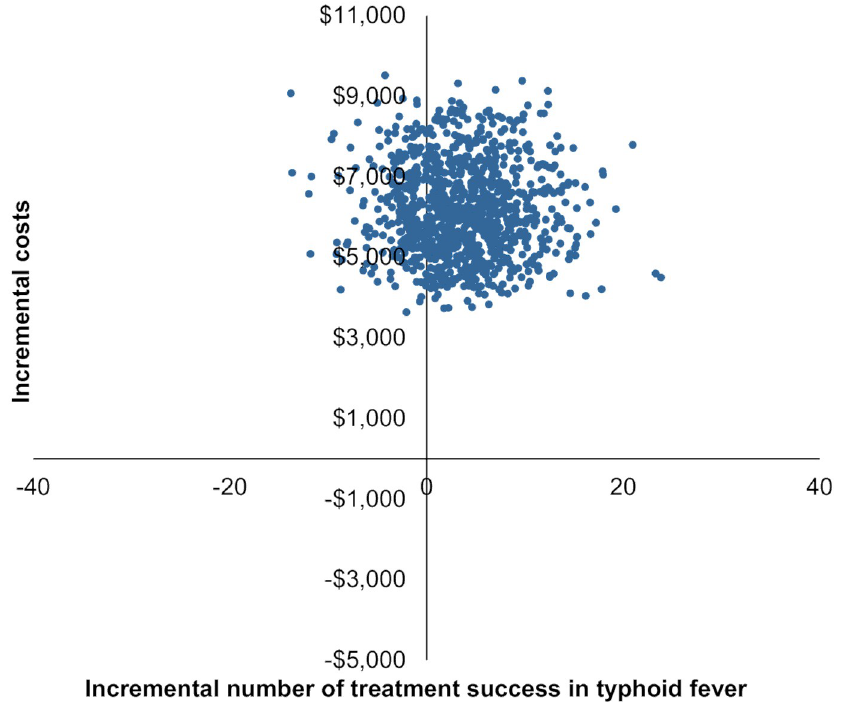
Fig 4. Cost-effectiveness plane in incremental number of treatment success and incremental cost.